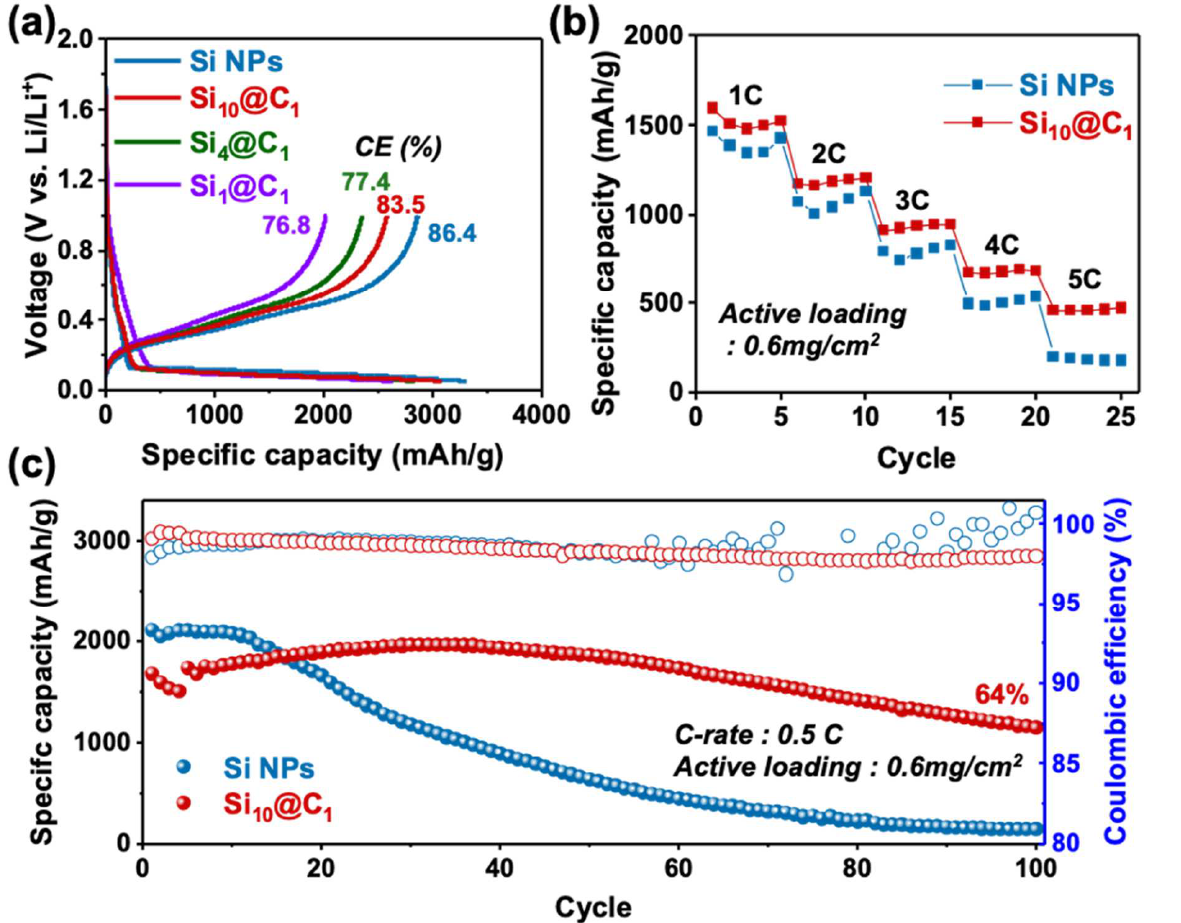
Figure 4. ( a ) Galvanostatic charge–discharge profiles for the Si@C ∥ Li half-cell; ( b ) the specific capacities of the Si- and Si 10 @C 1 -based half-cells at various C rates ranging from 1 C to 5 C; ( c ) cycling performance of the Si- and Si 10 @C 1 -based electrodes at a rate of 0.5 C .